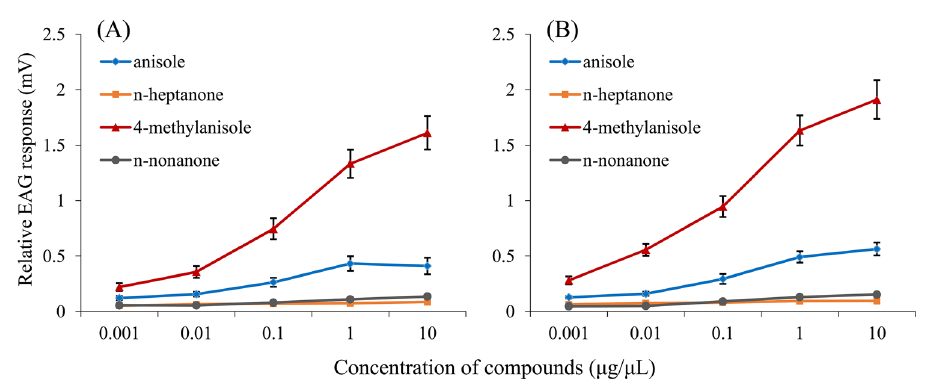
Figure 3. Dose-dependent EAG response curves to four volatile components. ( A ) male antennae; ( B ) female